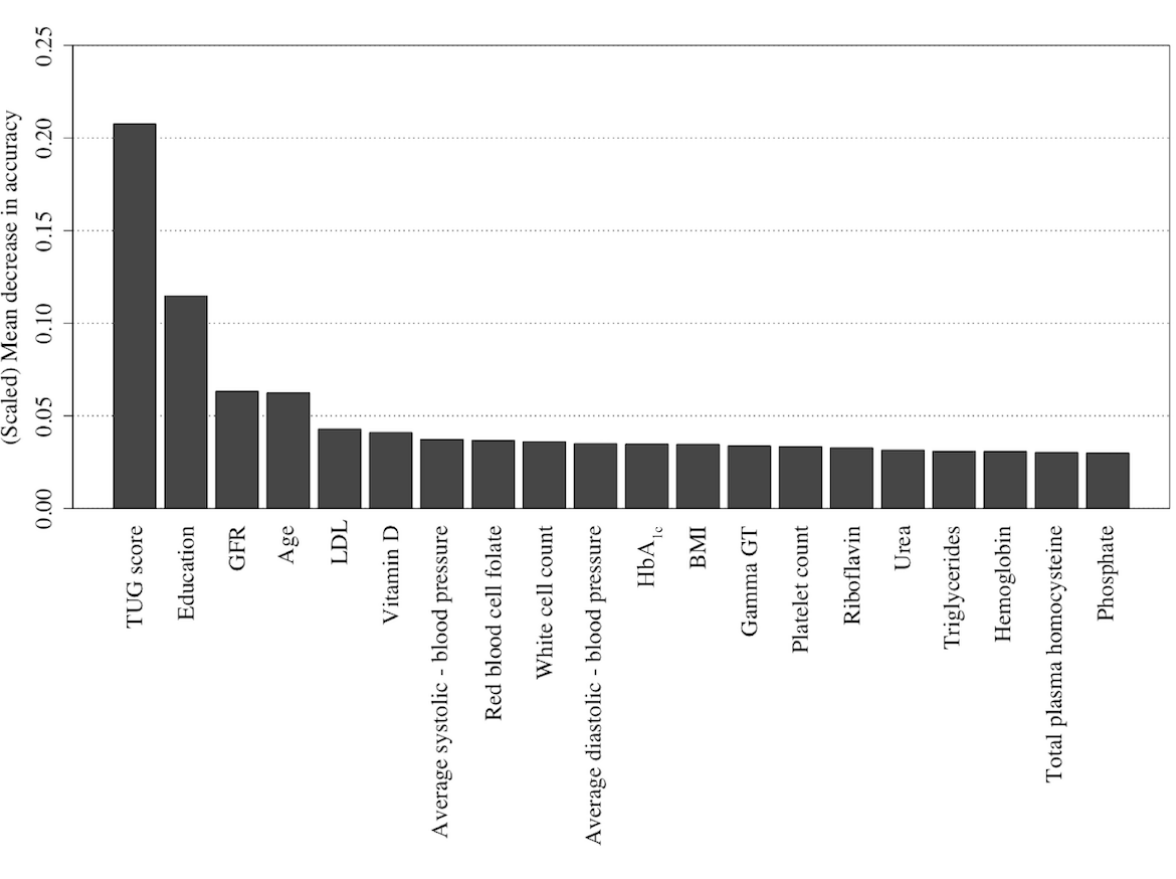
Table 4. Classification of the Repeatable Battery for the Assessment of Neuropsychological Status score performance measures when models trained with 10-fold cross-validation (training set size=2152) and the 4 key variables: (1) age at which the participant stopped education, (2) the Timed Up and Go score, (3) the glomerular filtration rate measure, and (4) the participant’s age.